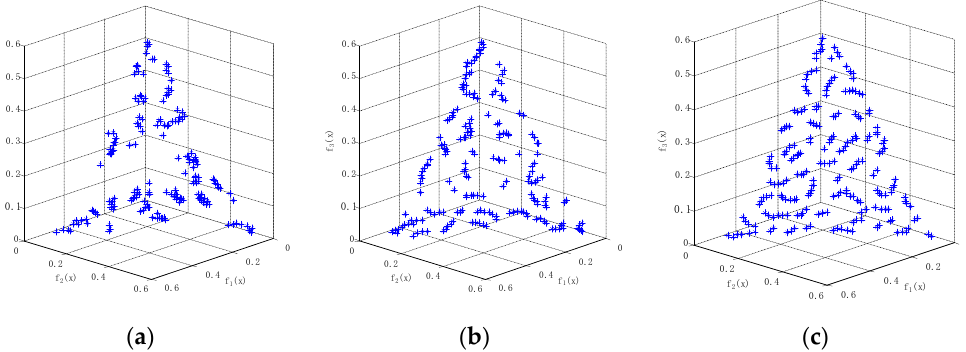
Figure 7. Pareto fronts of DTLZ 1 obtained by ( a ) MOPSO; ( b ) MOGWO; ( c ) HSMGWO.